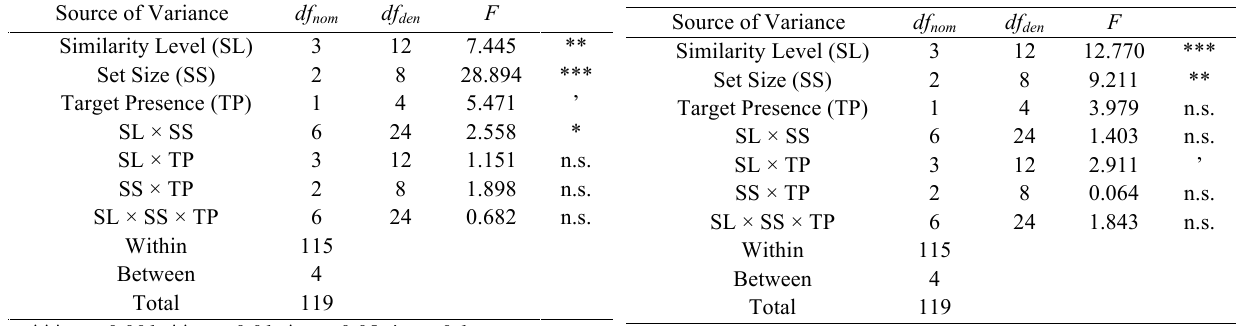
Three-way repeated measures analysis of variance for saccade amplitude.